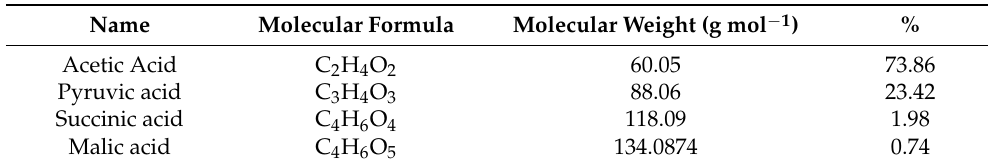
Figure 2. High pressure size exclusion chromatography (SEC-HPLC) for identification of chemical compounds in pyroligneous acid. X-axis represents retention time in minutes (R.time (min)). Y-axis represents intensity of absorbance in millivolts (mV). The dotted red line represents the range between the first and last detectable peak. Peaks observed at retention rates of 10.1, 10.7, and 12.4 min, labeled A, B, and C, were identified as humic and fulvic acids. Table 2. Percentage (mass within pyroligneous acid, m / v ) of detectable compounds in pyroligneous acid, analyzed by ion chromatography.